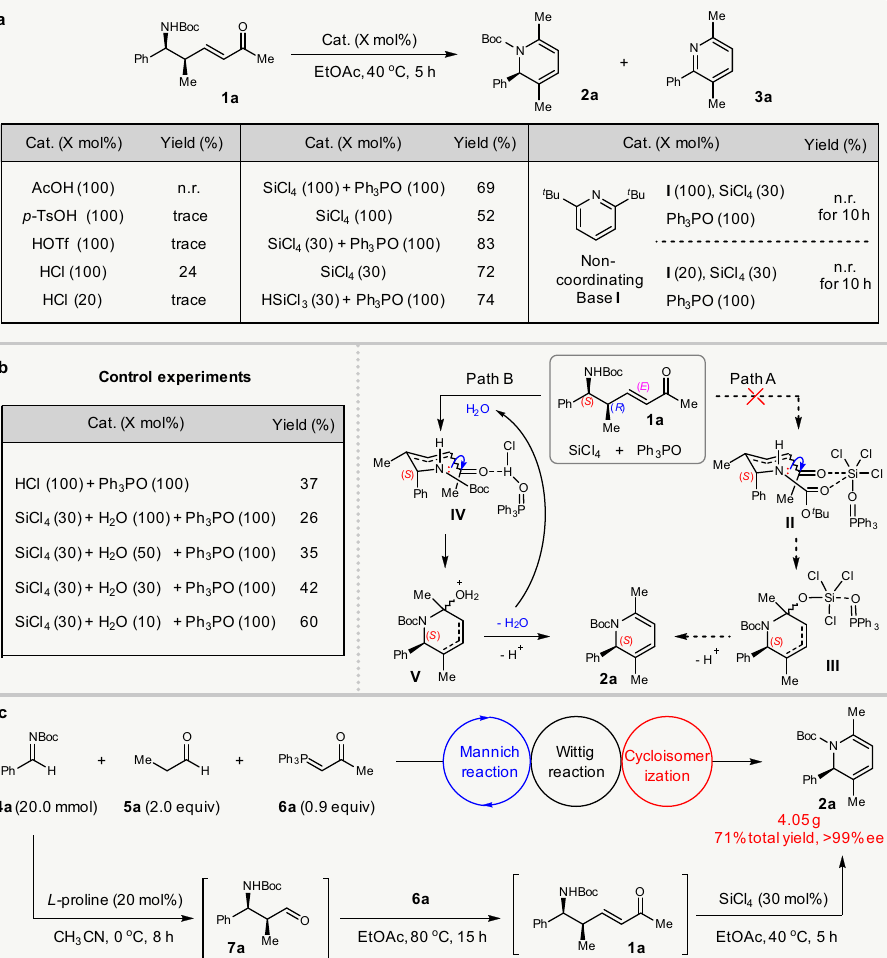
Fig. 2 Proof-of-principle study. a Optimization of conditions for the cycloisomerization of 1a . b Control experiments and possible mechanism. c Gram- scale asymmetric Mannich/Wittig/cycloisomerization sequence. Boc: tert -butyloxycarbonyl. EtOAc: ethyl